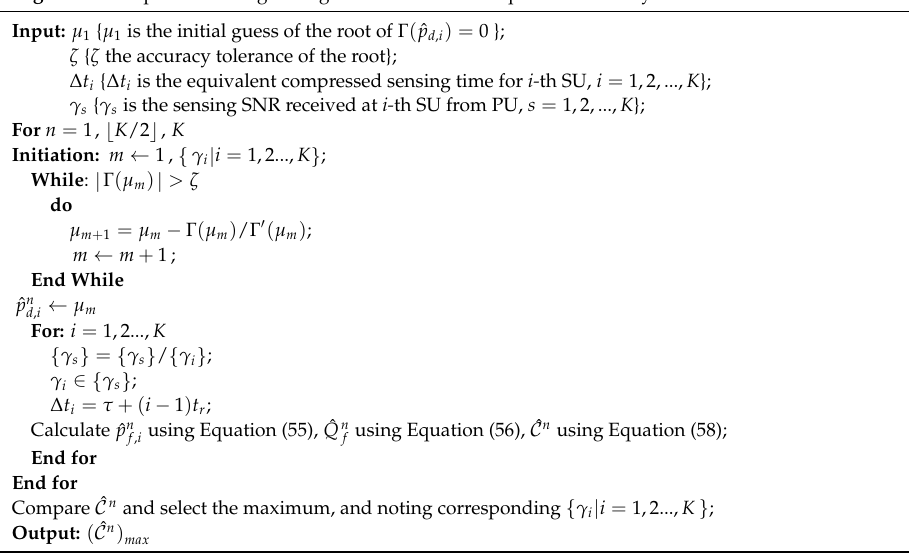
Algorithm 1. Optimal sensing settings that maximize the spectral